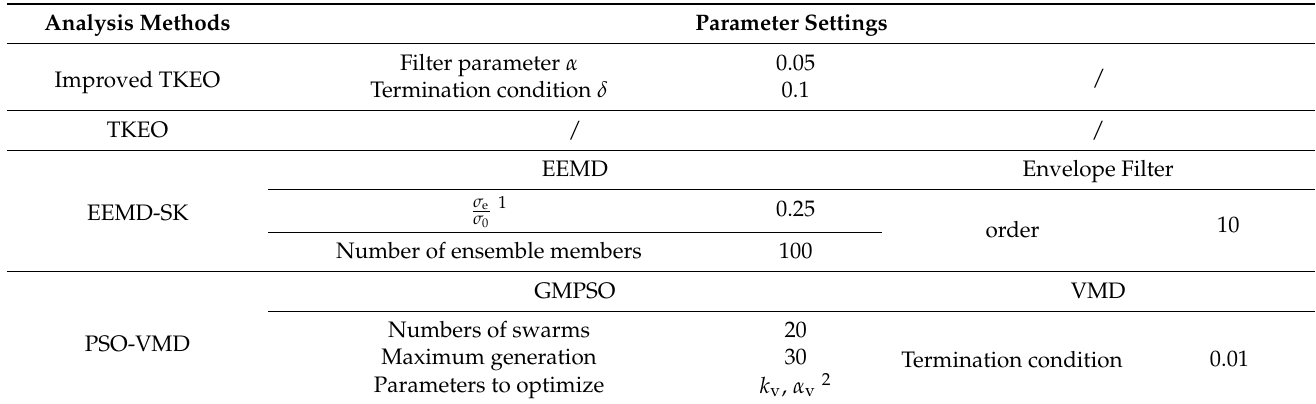
Figure 9. Vibration data of bearing 3. ( a ) The curve of maximum vibration amplitude versus time;